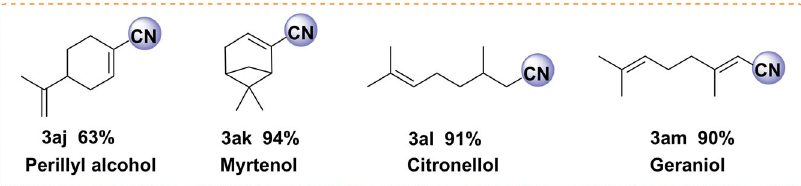
Fig. 7 Nitriles produced from renewable aliphatic alcohols. Reaction conditions: 0.2 mmol alcohol, 20 mg catalyst (3.9 mol% Fe), aq. NH 3 ·H 2 O (150